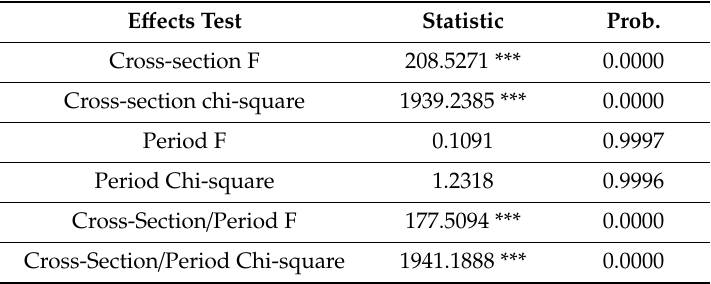
Table 5. Redundant Fixed E ff ects-likelihood ratio test.